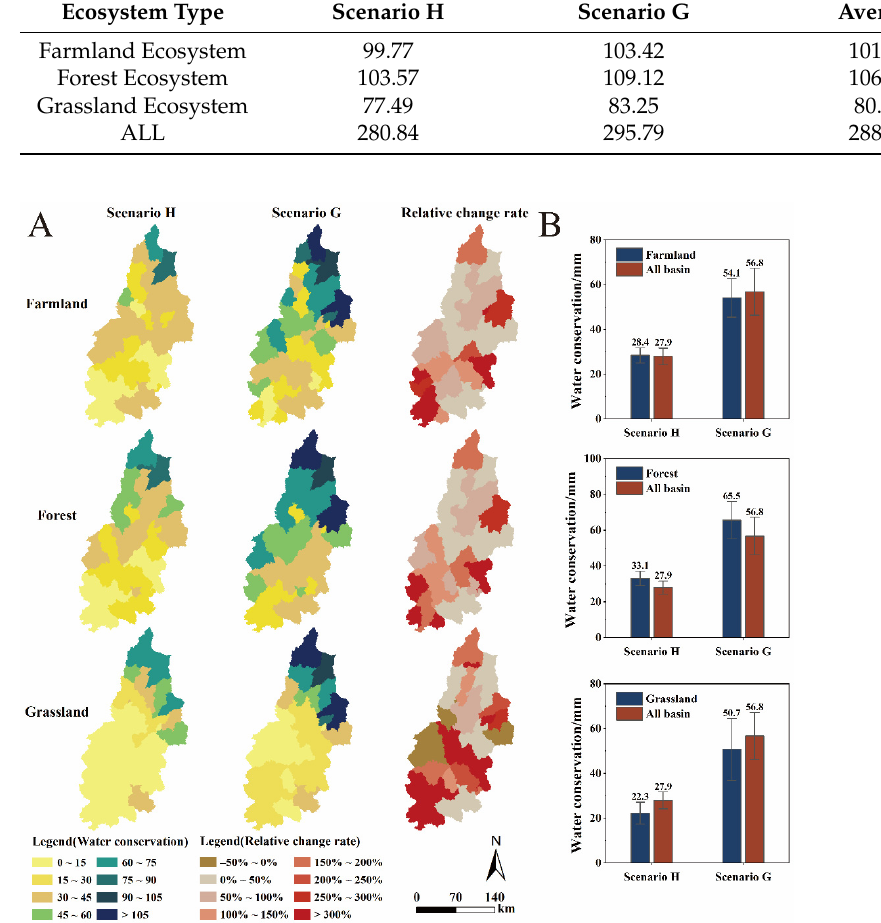
Figure 2. The spatial and temporal distribution of the WCA (mm) in each ecosystem during the dry season ( A ) versus relative changes ( B ).